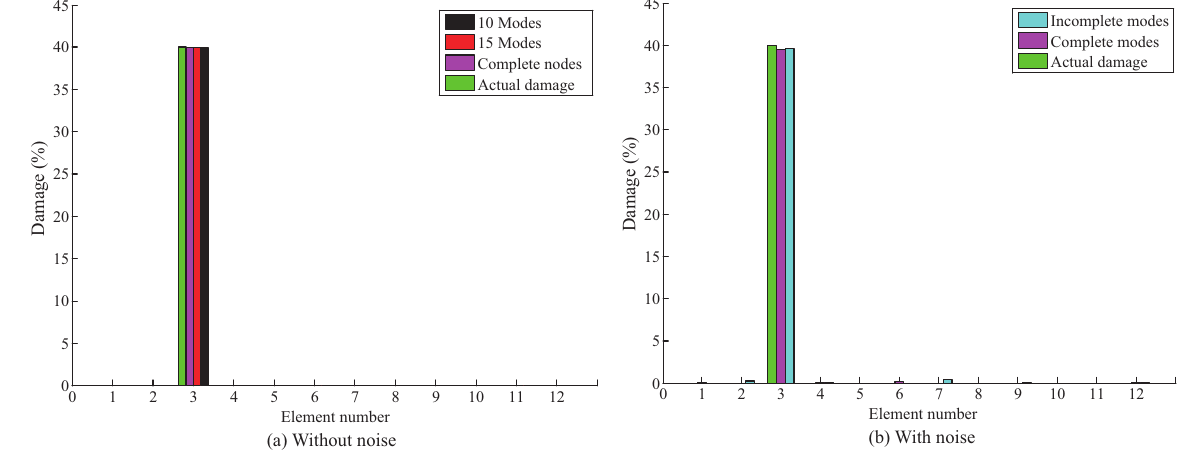
Fig. 3. Damage distribution of continuous beam using the complete and incomplete modal data in Scenario 1.